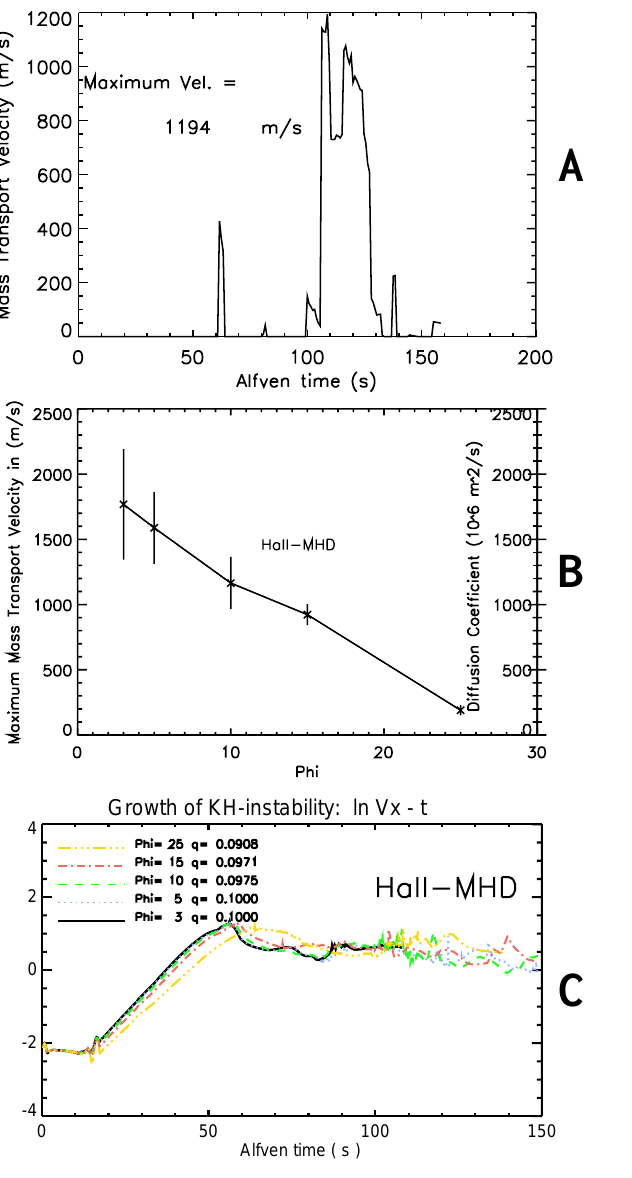
Fig. 8. (A) Mass transport velocity as a function of ϕ for MHD and Hall-MHD. (B) Growth of KH instability for ϕ = 3 ◦ , 5 ◦ , 10 ◦ , 15 ◦ and 25 ◦ for Hall-MHD approximation. (C) Growth of KH instabil- ity for MHD